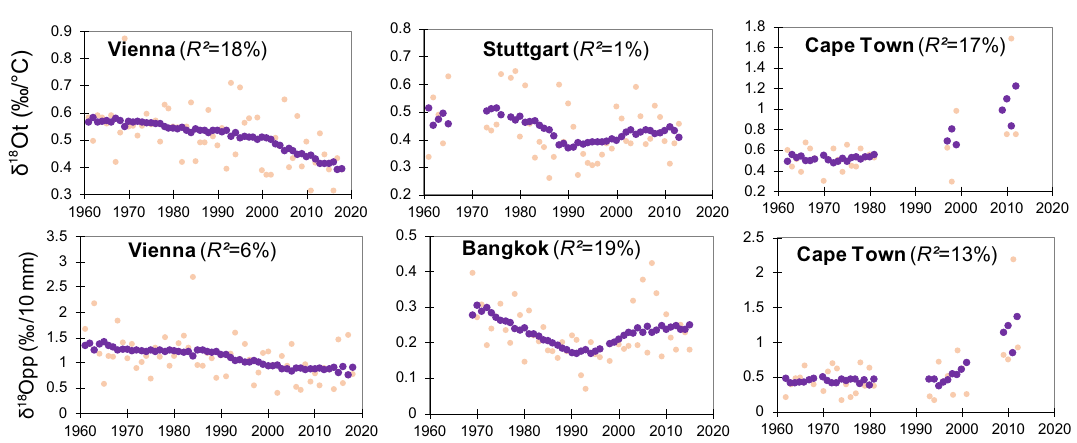
Figure 4. Nonparametric regression modelling (violet) of the annual time series of δ 18 O-dependency on T ( δ 18 O t ) and P ( δ 18 O pp